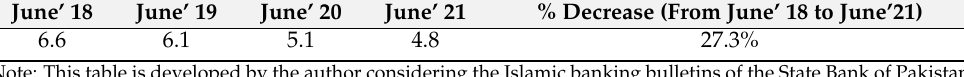
Table A2. Share of Ijarah in the financing portfolio of Islamic Bank (% share).